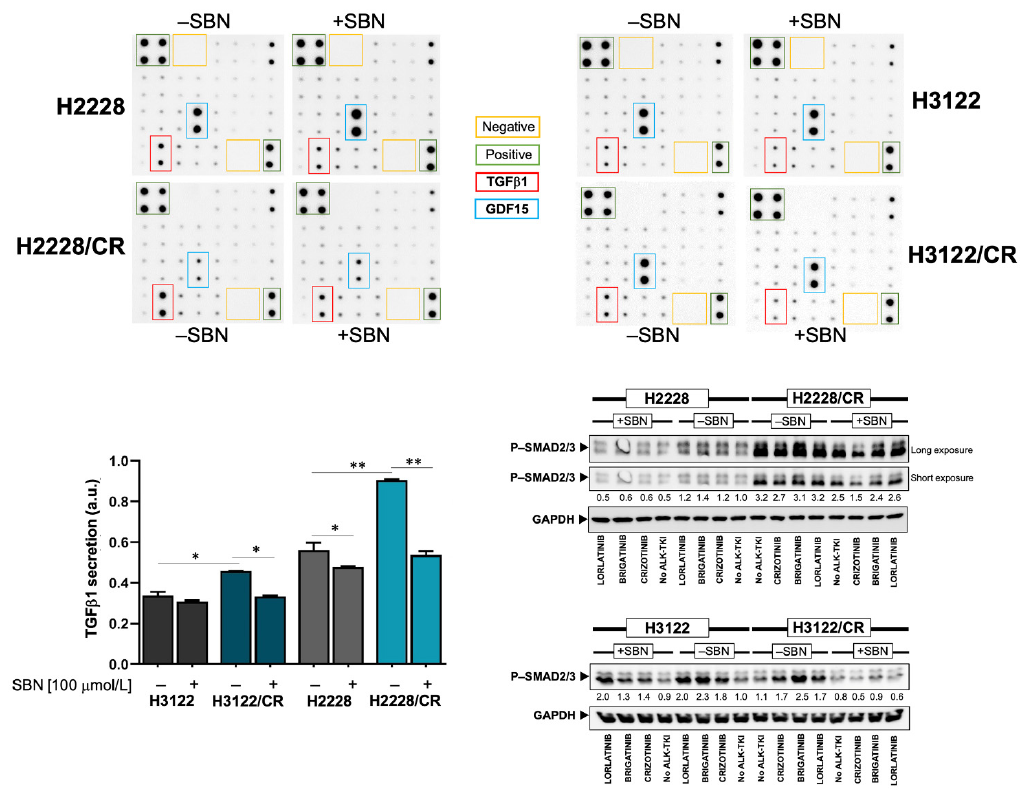
Figure 5. Effects of silibinin on the TGF β /SMAD signaling axis in ALK–TKIs-resistant NSCLC cells. Top: Low-serum (0.2% FBS), 24-hour-conditioned media from H2228/H2228CR and H3122/H3122CR cells cultured in the absence or presence of silibinin (100 µ mol/L) were assayed for the content of 25 TGF β -related secreted proteins, as described in the Materials and Methods section. Shown are representative results ( n = 3) revealing conspicuous changes in TGF β 1 and GDF15. Bottom left: The intensity of TGF β 1 dots was measured using the ImageJ software. Relative changes in TGF β 1 secretion were calculated following subtraction of membrane background signal and normalization to positive control readings. Bottom right: Expression levels of phospho-SMAD2/3 were detected by immunoblotting in H2228/H2228CR and H3122/H3122CR cells treated with crizotinib, brigatinib or lorlatinib (1 µ mol/L, 24 h) in the absence/presence of silibinin (100 µ mol/L) using a specific antibody. The intensity of the bands was measured using the ImageJ software. The fold-change of each protein relative to untreated samples was calculated using GAPDH as a loading control. The figure shows representative immunoblots of multiple ( n = 3) independent experiments. The uncropped